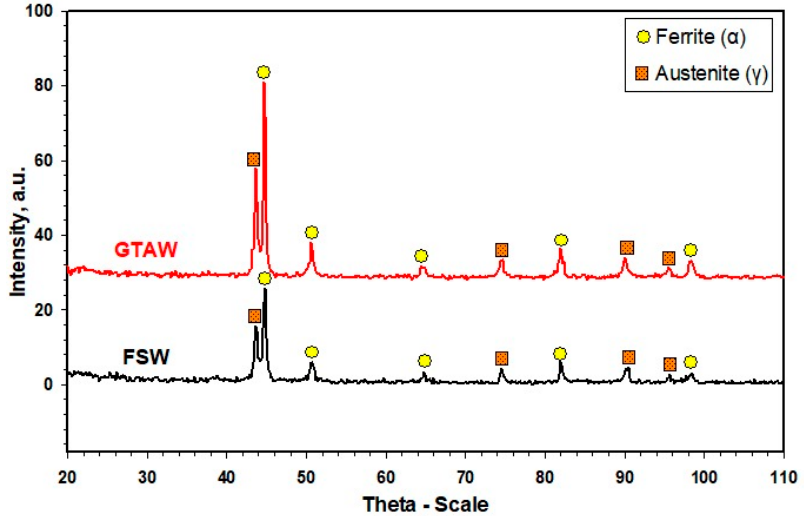
Figure 11. XRD patterns of the 2205 DSS FSWed joint produced using a 60 o V groove with root face and GTAWed butt